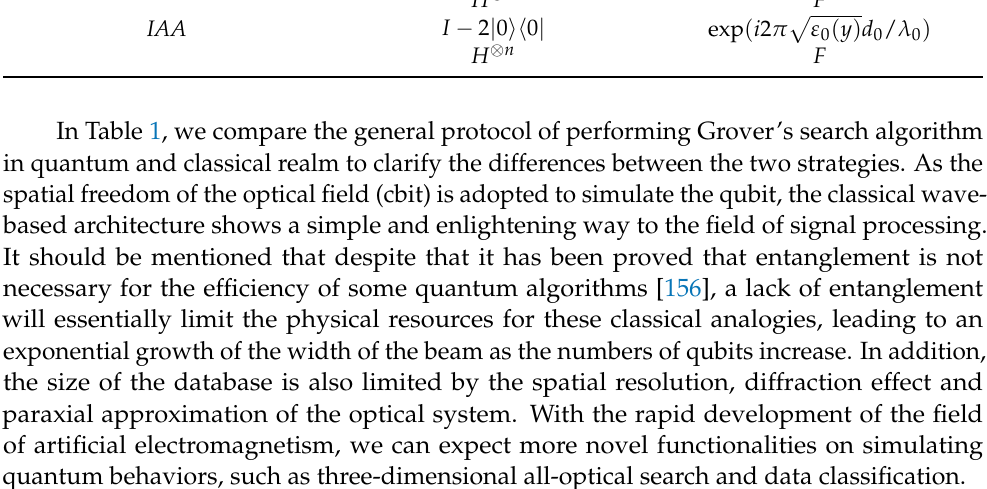
Figure 13. ( a ) Schematic of the general protocol of simulating quantum search algorithm with metamaterials. ( b ) Experi- mental results of the time traces (top) and the field intensity (bottom) of the output with different iterations. Adapted with permission from [154], Wiley, 2017. ( c ) Simulation results of metamaterial-based DJ algorithm analogy with constant, simple balance and complex balance functions, respectively. ( d ) The photograph (top) and experimental results of three samples for simulating DJ algorithm. Adapted with permission from [155] © The Optical Society. Table 1. The general protocol of performing Grover’s search algorithm with metamaterial in quantum and classical realm. Quantum Classical Items in the database | i (cid:105) “ y ” Probability amplitude of the equivalent quantum state “ E(y )” The maximum number of the database N “ D ” U